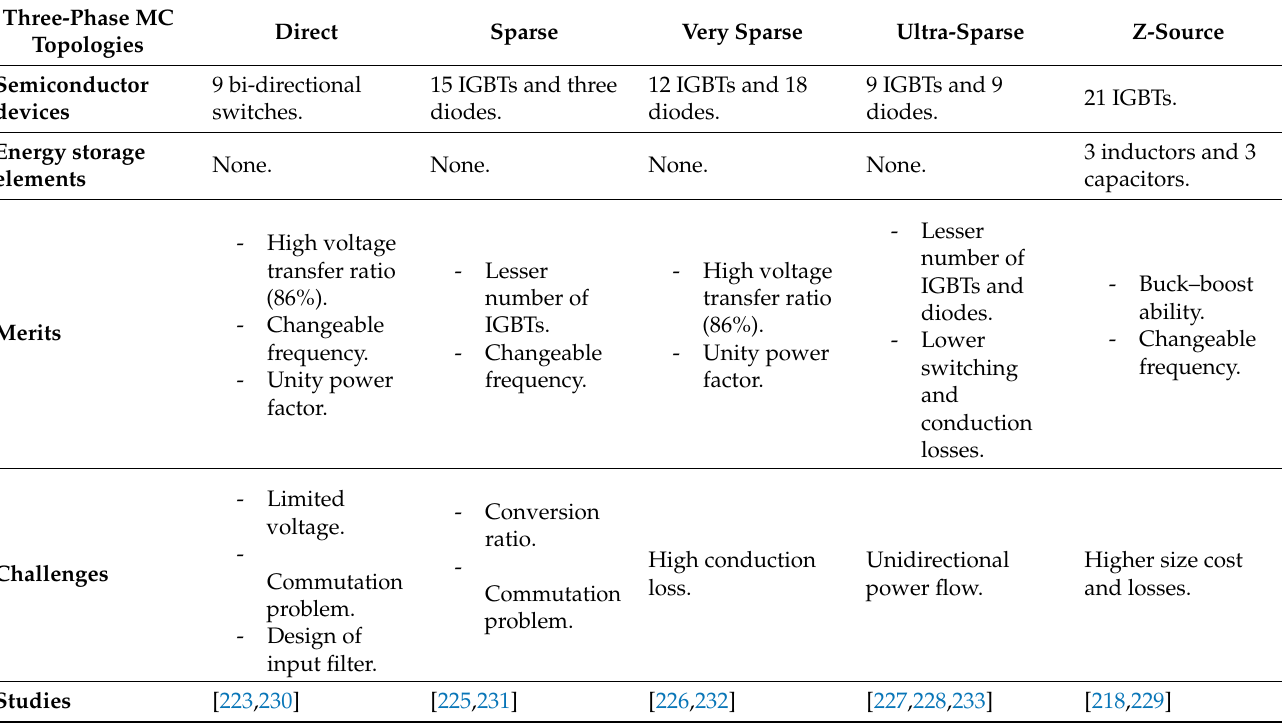
Figure 20. Types of three-phase matrix converter (MC): ( a ) direct MC, ( b ) indirect MC, and ( c ) three-phase Z-source MC. Table 10. Various types of single-phase MC topologies.